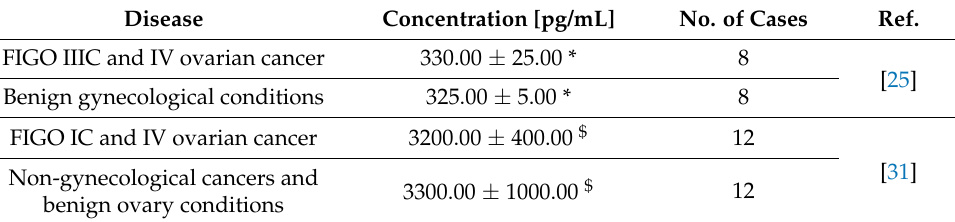
Table 7. Concentrations of monocyte chemotactic protein-1 (MCP-1) in ascites. Disease Concentration [pg/mL] No. of Cases Ref. FIGO IIIC and IV ovarian cancer 330.00 ± 25.00 * 8 [25] Benign gynecological conditions 325.00 ± 5.00 * 8 FIGO IC and IV ovarian cancer 3200.00 ± 400.00 $ 12 [31]Non-gynecological cancers and 3300.00 ± 1000.00 $ 12 benign ovary conditions